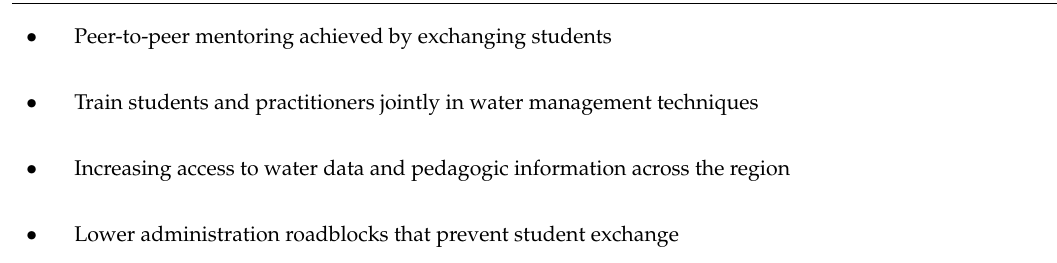
Table 2. Recommended best practices for closing an education gap in the Latin America and Caribbean (LAC) region based on experiences in the Water Management and Climate Change in the Focus of International Master Programs (Watermas) using Cuba and Ecuador as case studies. Recommended Best Practices for Closing the Education Gap in the Latin America and Caribbean (LAC)